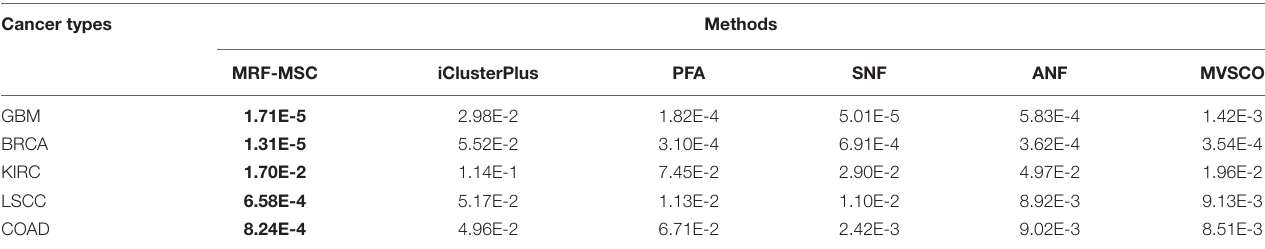
TABLE 3 | Comparison of P -values of survival analysis between MRF-MSC and other algorithms on five cancer multi-omics data sets in Wang et al. (2014). Cancer